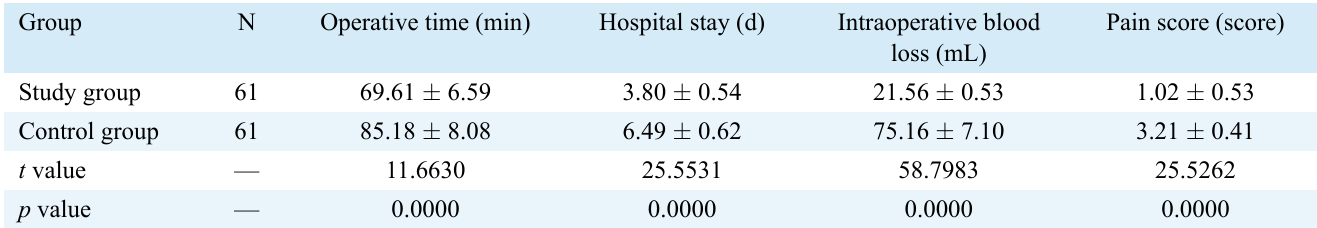
TABLE 3. Comparison of clinical surgical indicators between study and control groups ( ¯ x ± s ).